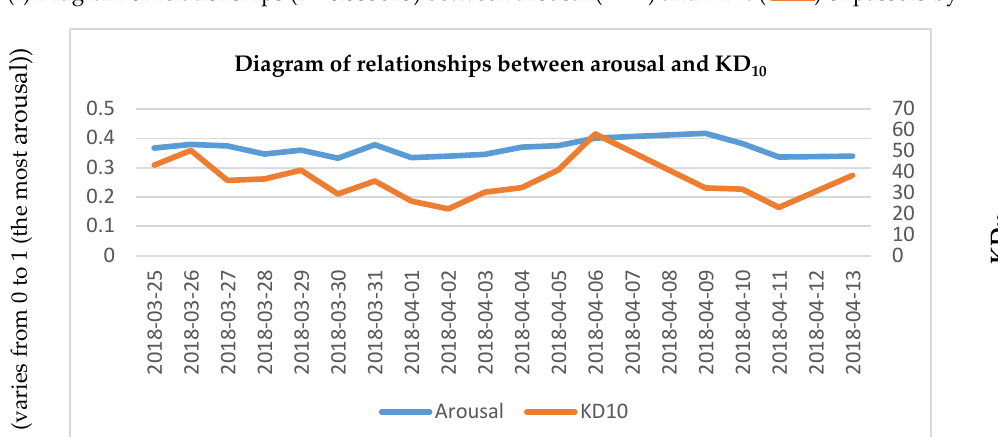
Diagram of relationships between arousal and KD